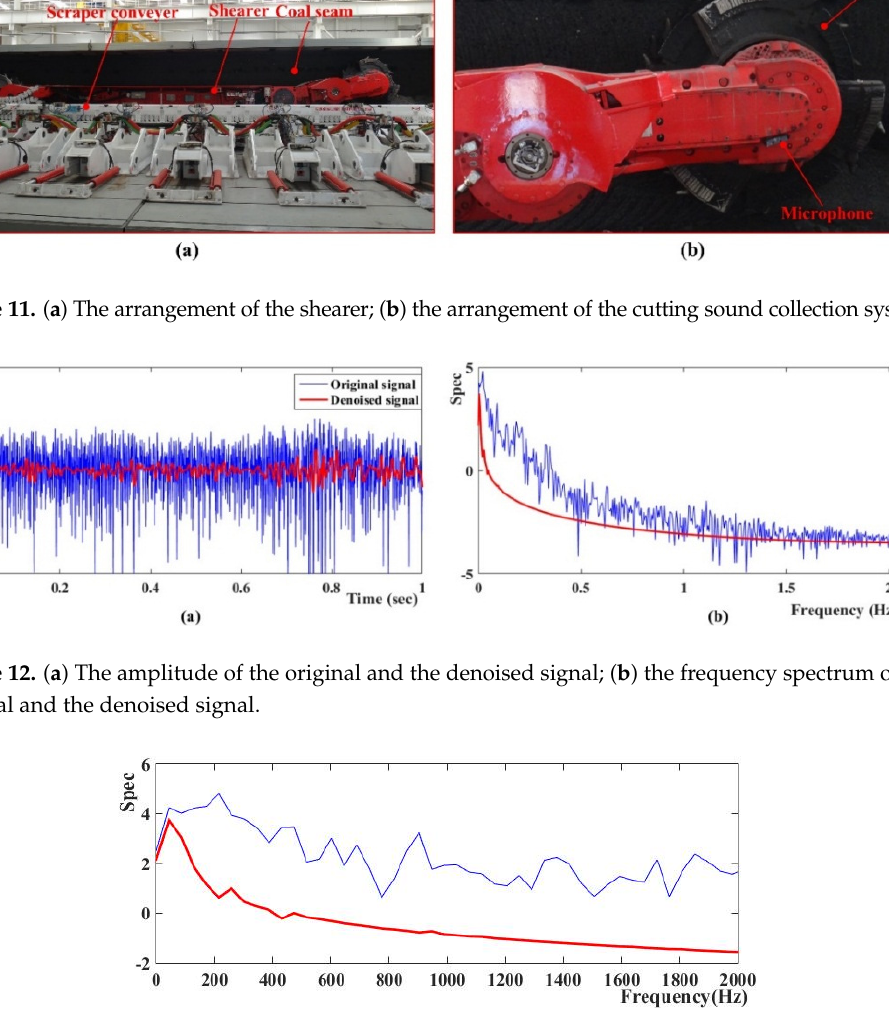
Figure 13. The zoom on the range of [0, 2000 Hz] of the frequency spectrum.